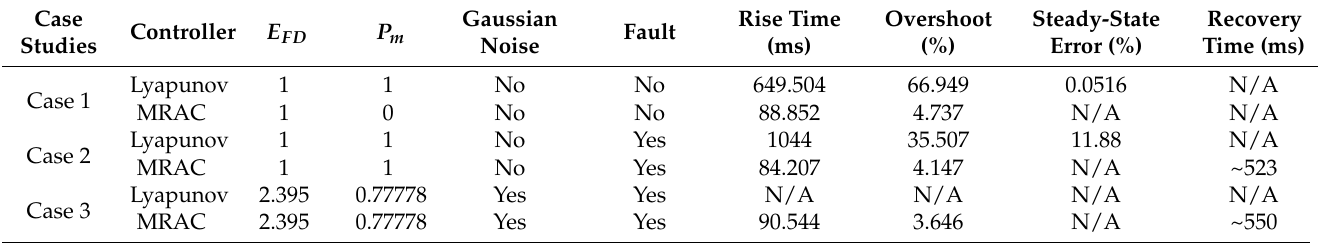
Table 1. Performance characteristics of the Lyapunov-based tracking controller and